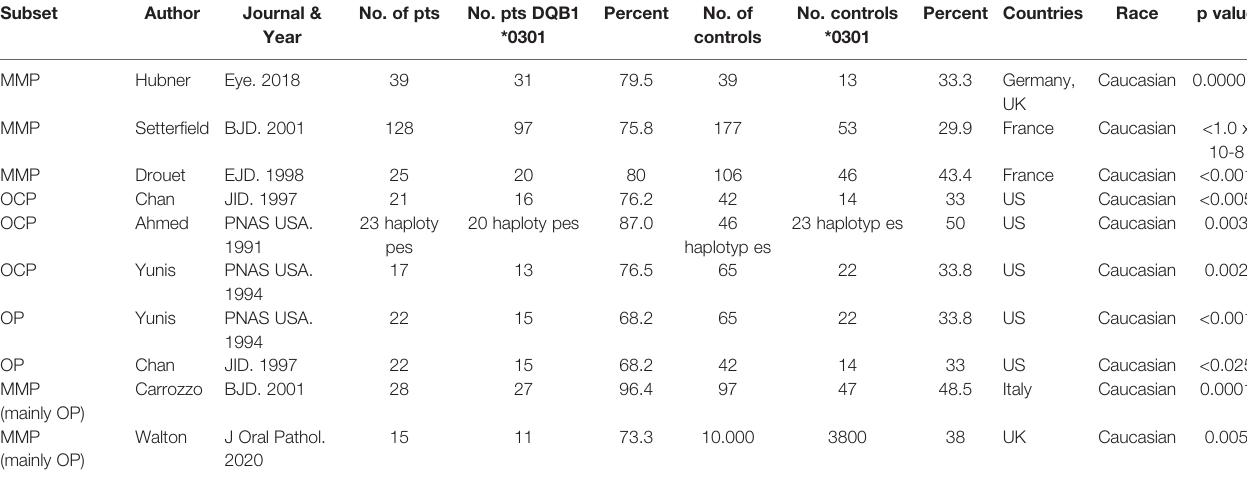
TABLE 1 | HLA DQB1*03:01 allele frequencies in bullous pemphigoid.